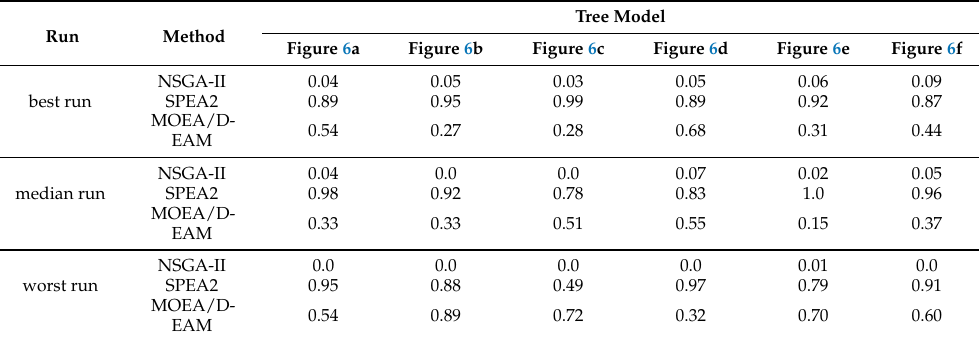
Table 3. The RNI values for non-dominated sets produced by best, median, and worst runs of each optimization method. The metric is computed across the combined results of all three methods for a given run.